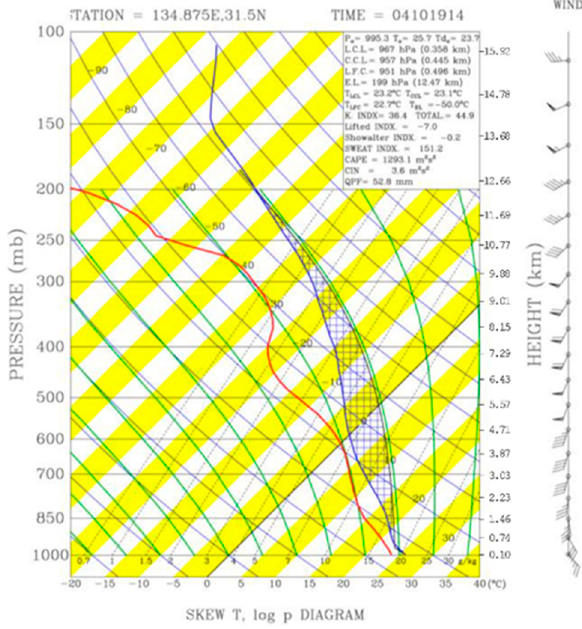
Figure 7. Skew T -log p plot of vertical profiles of temperature, dew-point temperature, and horizontal winds (kt) at 31.5 °N, 134.875 °E (cf. Figure 6a for location) at 1400 UTC 19 October 2004 in the simulation. The process curve for the surface air parcel is plotted. For winds, pennants, full barbs, and half barbs denote 50 kts, 10 kts, and 5 kts, respectively.